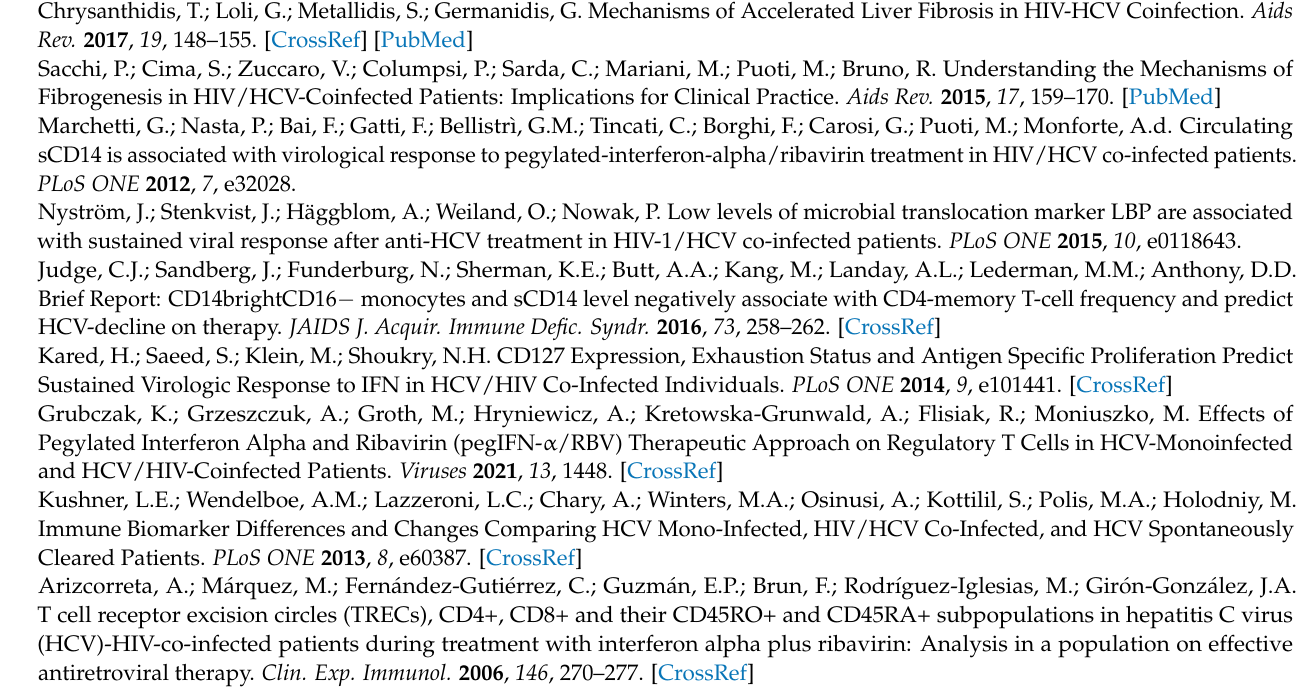
Figure S2: Gating stratgey for γδ cells; Figure S3: Gating stratgey for